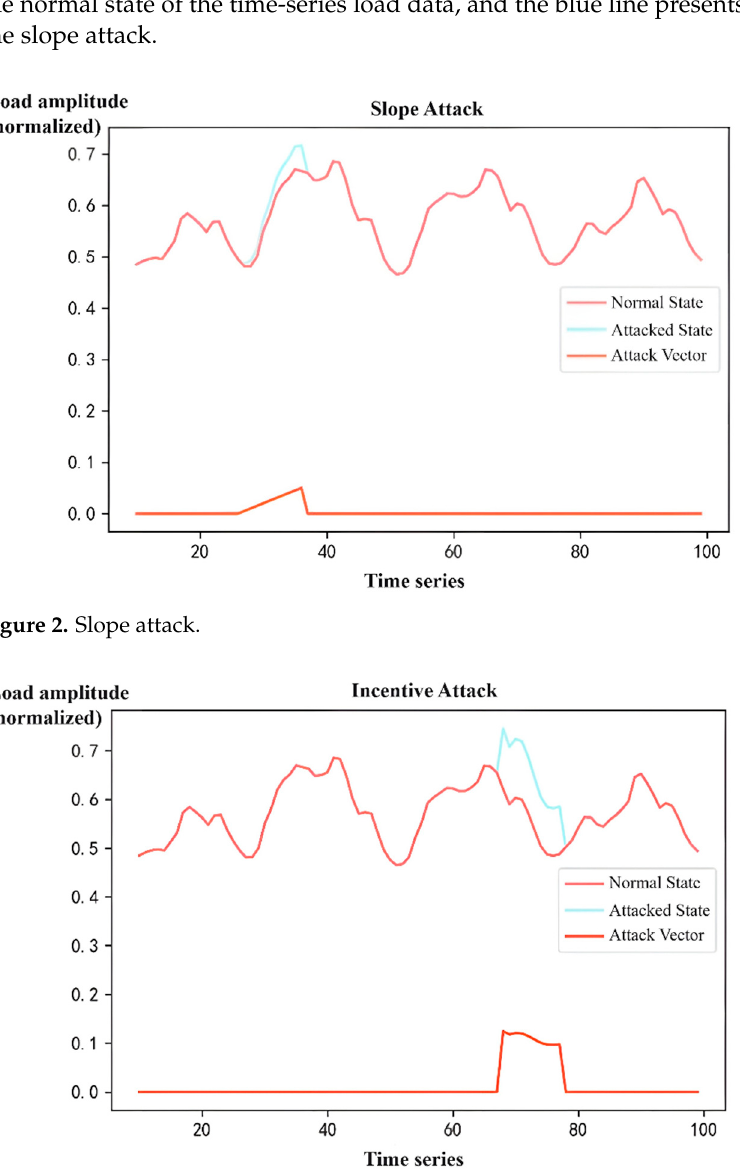
Figure 4. Delay attack. To observe the change in the time-frequency features under the three attack modes, the time-frequency transform methods of DWT, EMD, and EWT were applied to the case data. As for the setting of DWT, it can be seen from Equation (1) that the selection of wave- let functions ψ m , n ( k ) and the decomposition level m can lead to different decomposition coefficients. These coefficients will further affect the feature extraction ability of a DWT- based feature extractor. Although the best setting of wavelet function and decomposition level m to achieve the best detection performance exists, it is impractical to test all types of wavelet functions. In this paper, the bior wavelet was chosen as the basis wavelet func- tion in consideration of its biorthogonality and compact support by MATLAB. In addition, the mode components decomposed by EMD and EWT together form the original time- series data, and the coefficients of all mode function components are retained for feature extraction. Figures 5–7 present the decomposition coefficients of DWT, EMD, and EWT under the three attack modes, where the results of DWT only preserve the first-level detail